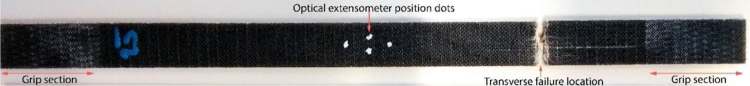
Tested Flax-0 specimen showing failure location.